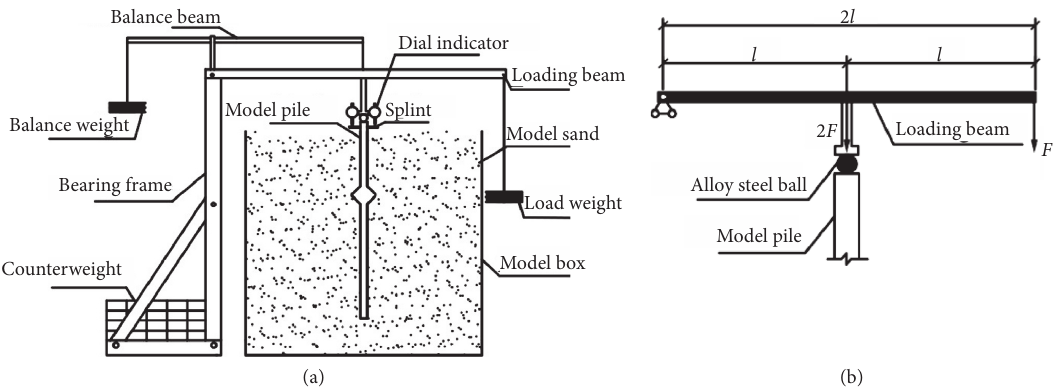
Figure 5: Loading device: (a) schematic diagram of loading device and (b) details of loading points.